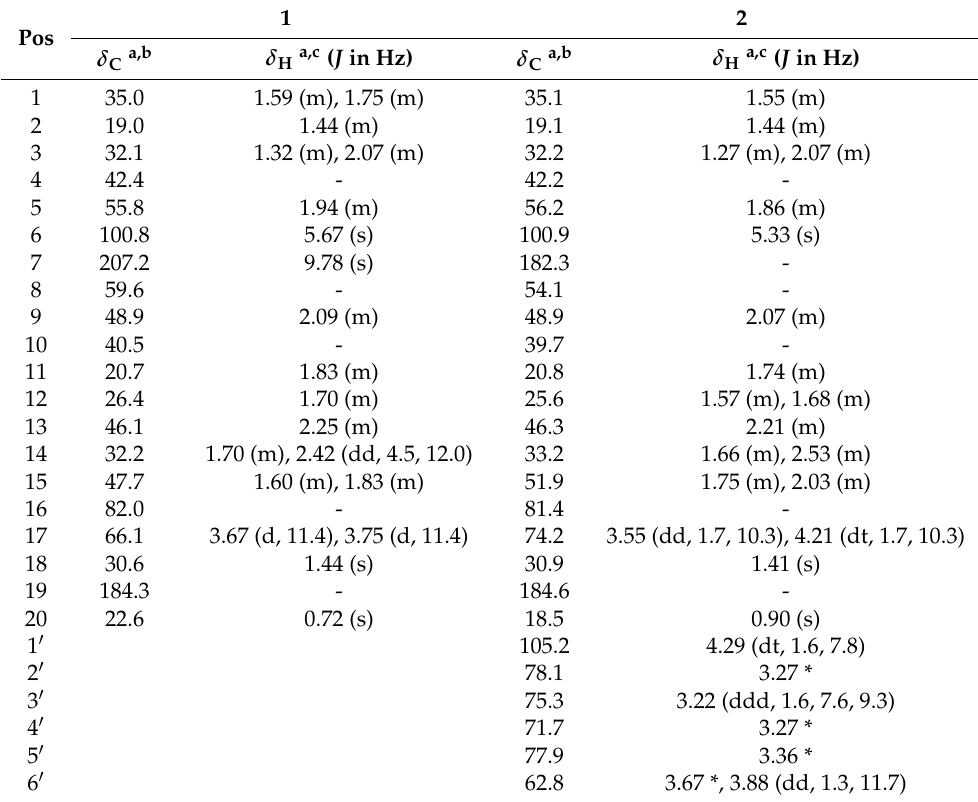
Table 1. NMR spectroscopic data for compounds 1 – 2